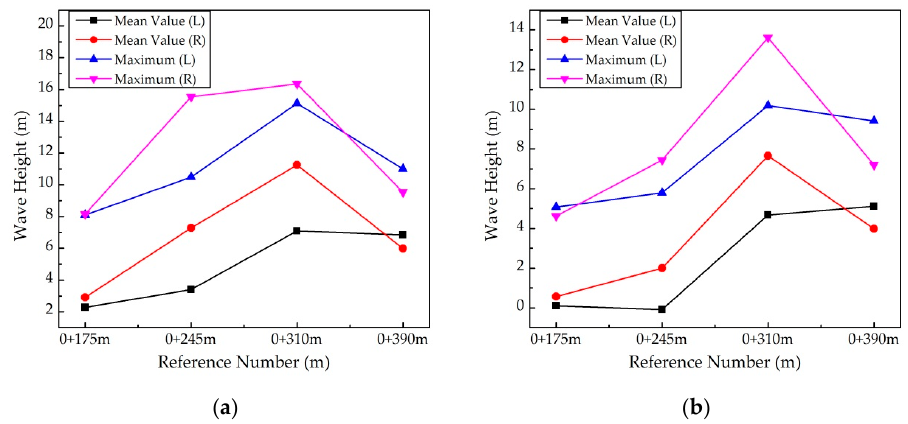
Figure 14. Mean and maximum wave height values along the reference numbers of both slopes under operating Conditions 1 and 2. ( a ) Condition 1; and ( b ) Condition